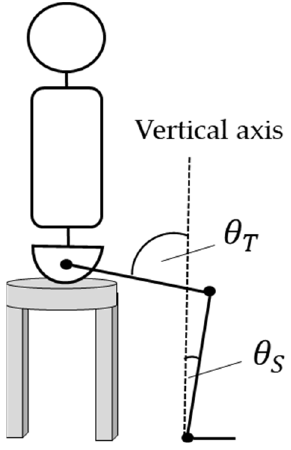
Figure 3. Definition of EAs for the thigh and the lower leg. The EA was measured using KineAnalyzer. The angle between the vertical axis and the thigh axis was defined as θ T , and the angle between the vertical axis and the lower leg was defined as θ S